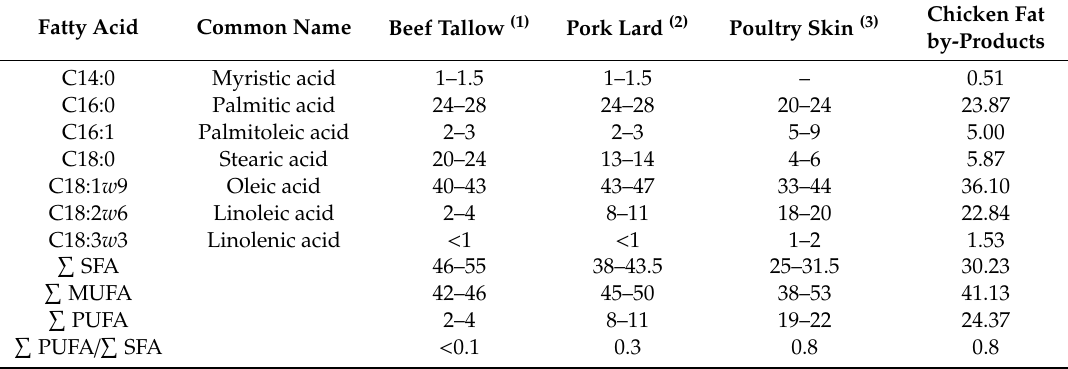
Table 5. Lipid profile (%) of traditional fat sources in the meat industry, according to the literature, and of chicken fat by-products analyzed in this